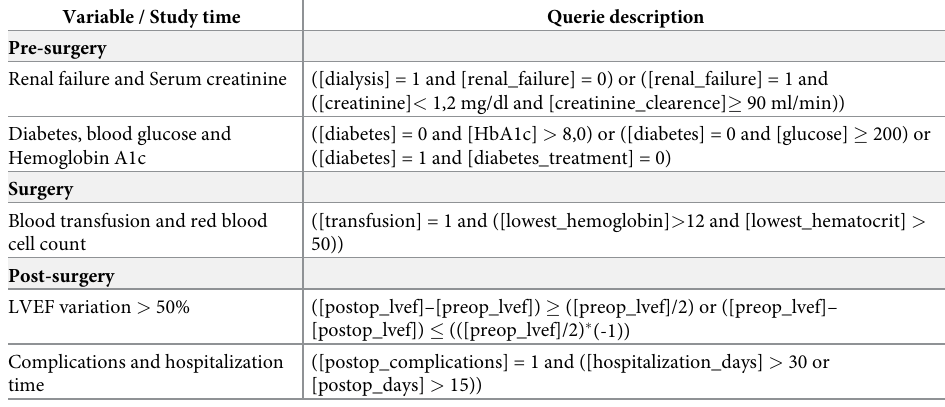
Table 1. REPLICCAR queries examples. REPLICCAR II, 2019. Variable / Study